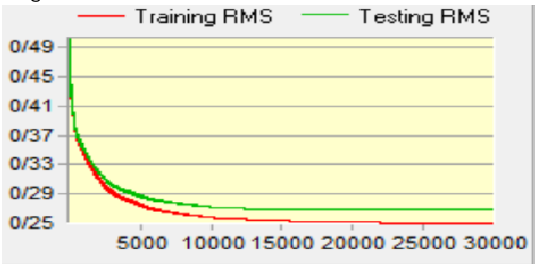
Figure 8. The average of training and testing